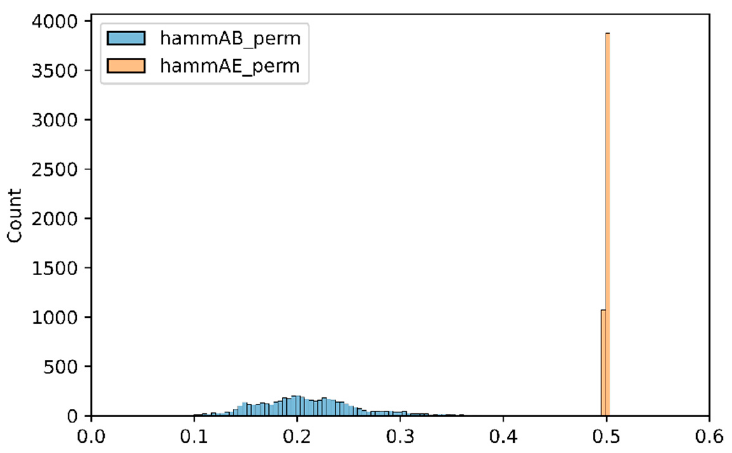
Figure 8. Histogram of normalized Hamming distances between Alice and Bob (0.2111 ± 0.0511), and Alice and Eve (0.4999 ± 0.0010), after applying a random permutation to Alice’s and Bob’s sequence.